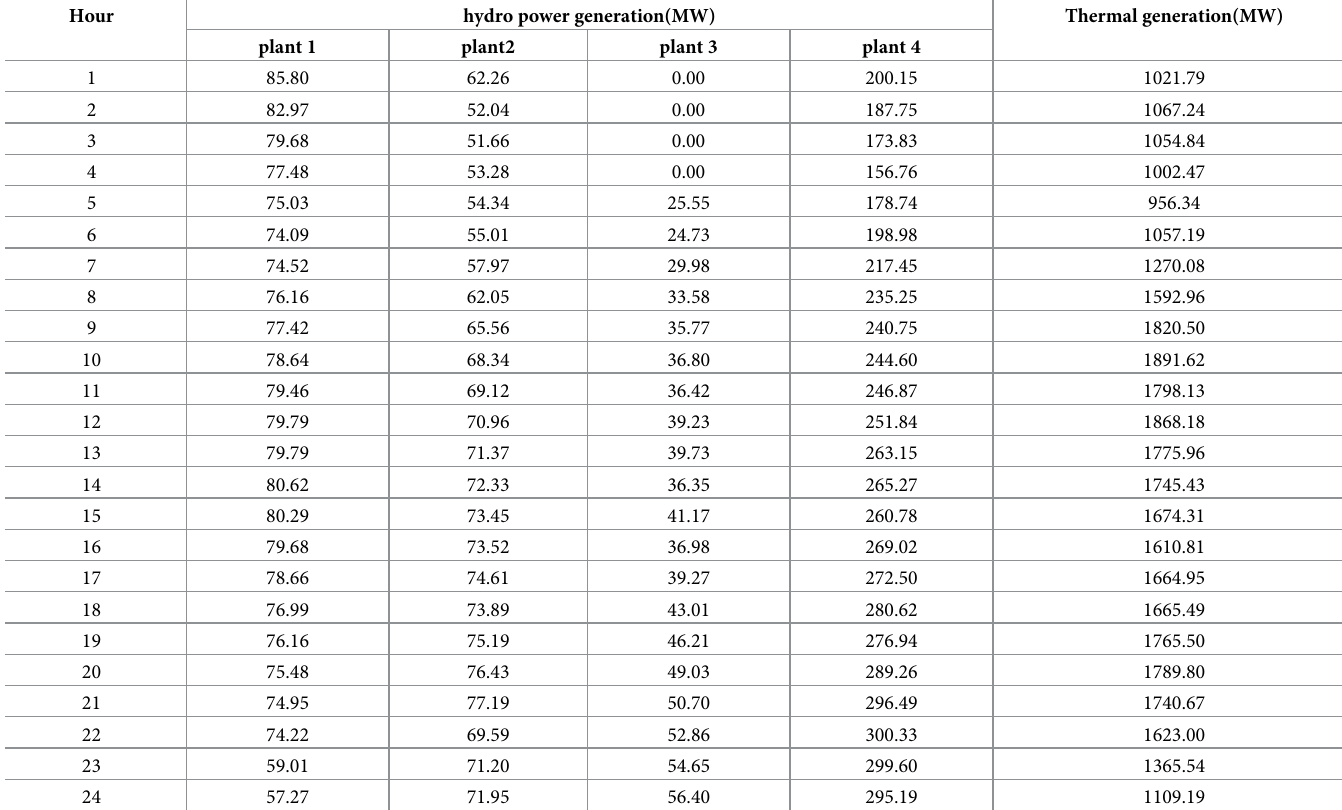
Table 7. Hourly generation of each plant.